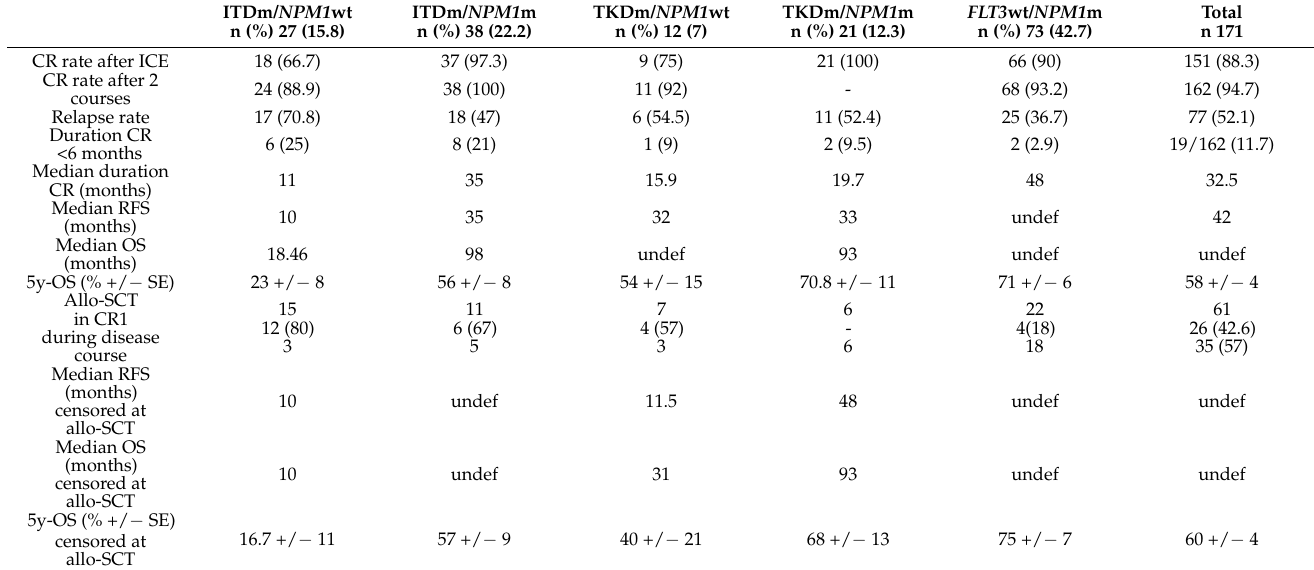
Table 2. Complete Response, duration of CR, relapse rate, RFS, and OS, according to molecular groups. ITDm/ NPM1 wt n (%) 27